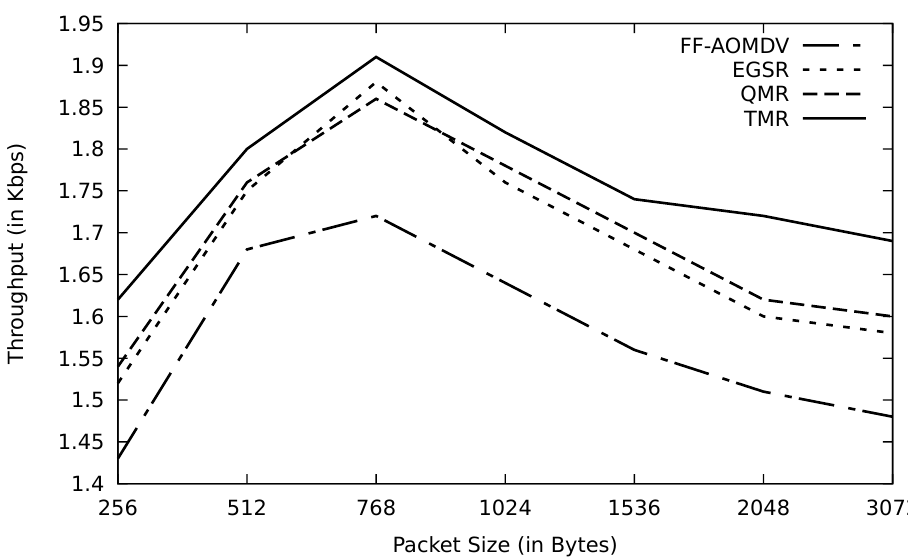
Figure 9. Comparison of FF-AOMDV, EGSR, QMR, and proposed protocol TMR for throughout with different packet sizes.